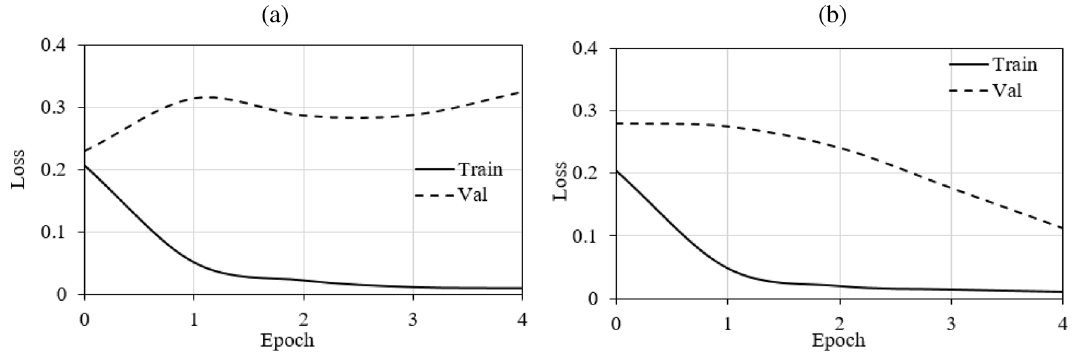
Figure 5. Training and validation loss of models with ( a ) noisy data and ( b ) cleaned data; Train training; Val